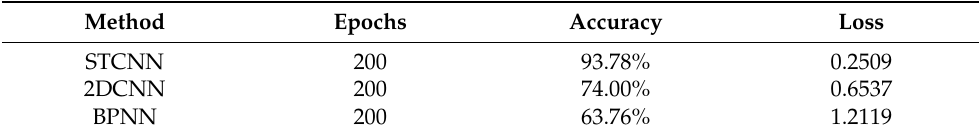
Table 1. Comparison of prediction results of three methods.